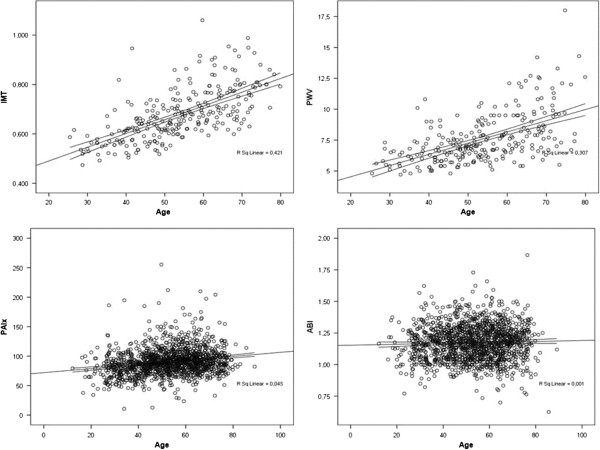
Scatterplots representing the relationship between age and each vascular structure and functional parameter analysed (PWV r = 0.558; p < 0.01, IMT r = 0.687; p < 0.01, PAIx75 r = 0.222; p < 0.01 and ABI r = 0.045; p > 0.05).